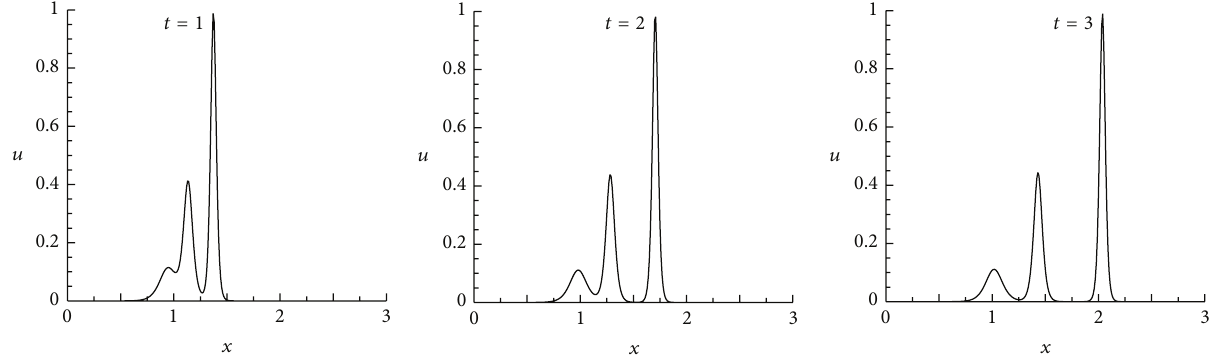
Figure 6: Triple soliton solutions for equation 𝑢 𝑡 + 𝑢𝑢 𝑥 + 𝜀𝑢 𝑥𝑥𝑥 = 0 of Example 3 at various time